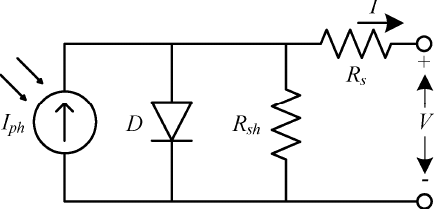
Figure 9. PV cell single diode model equivalent circuit.